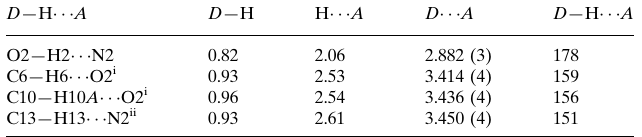
Hydrogen-bond geometry (A˚ , (cid:2)